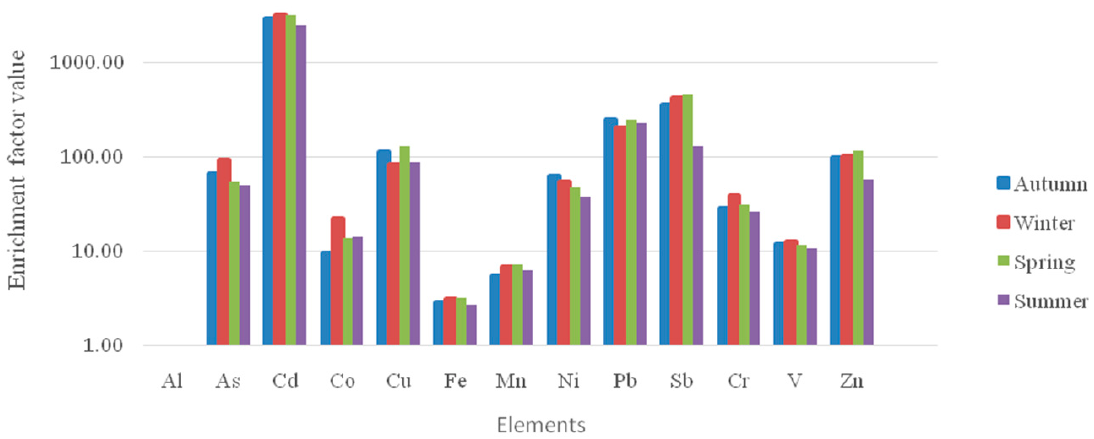
Figure 2. Crustal enrichment factor (EnF) for the elements based on average seasonal metal concentrations.